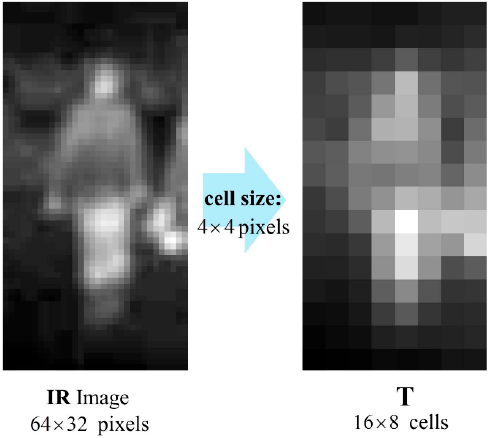
Figure 3. Example of IR image and its T channel.